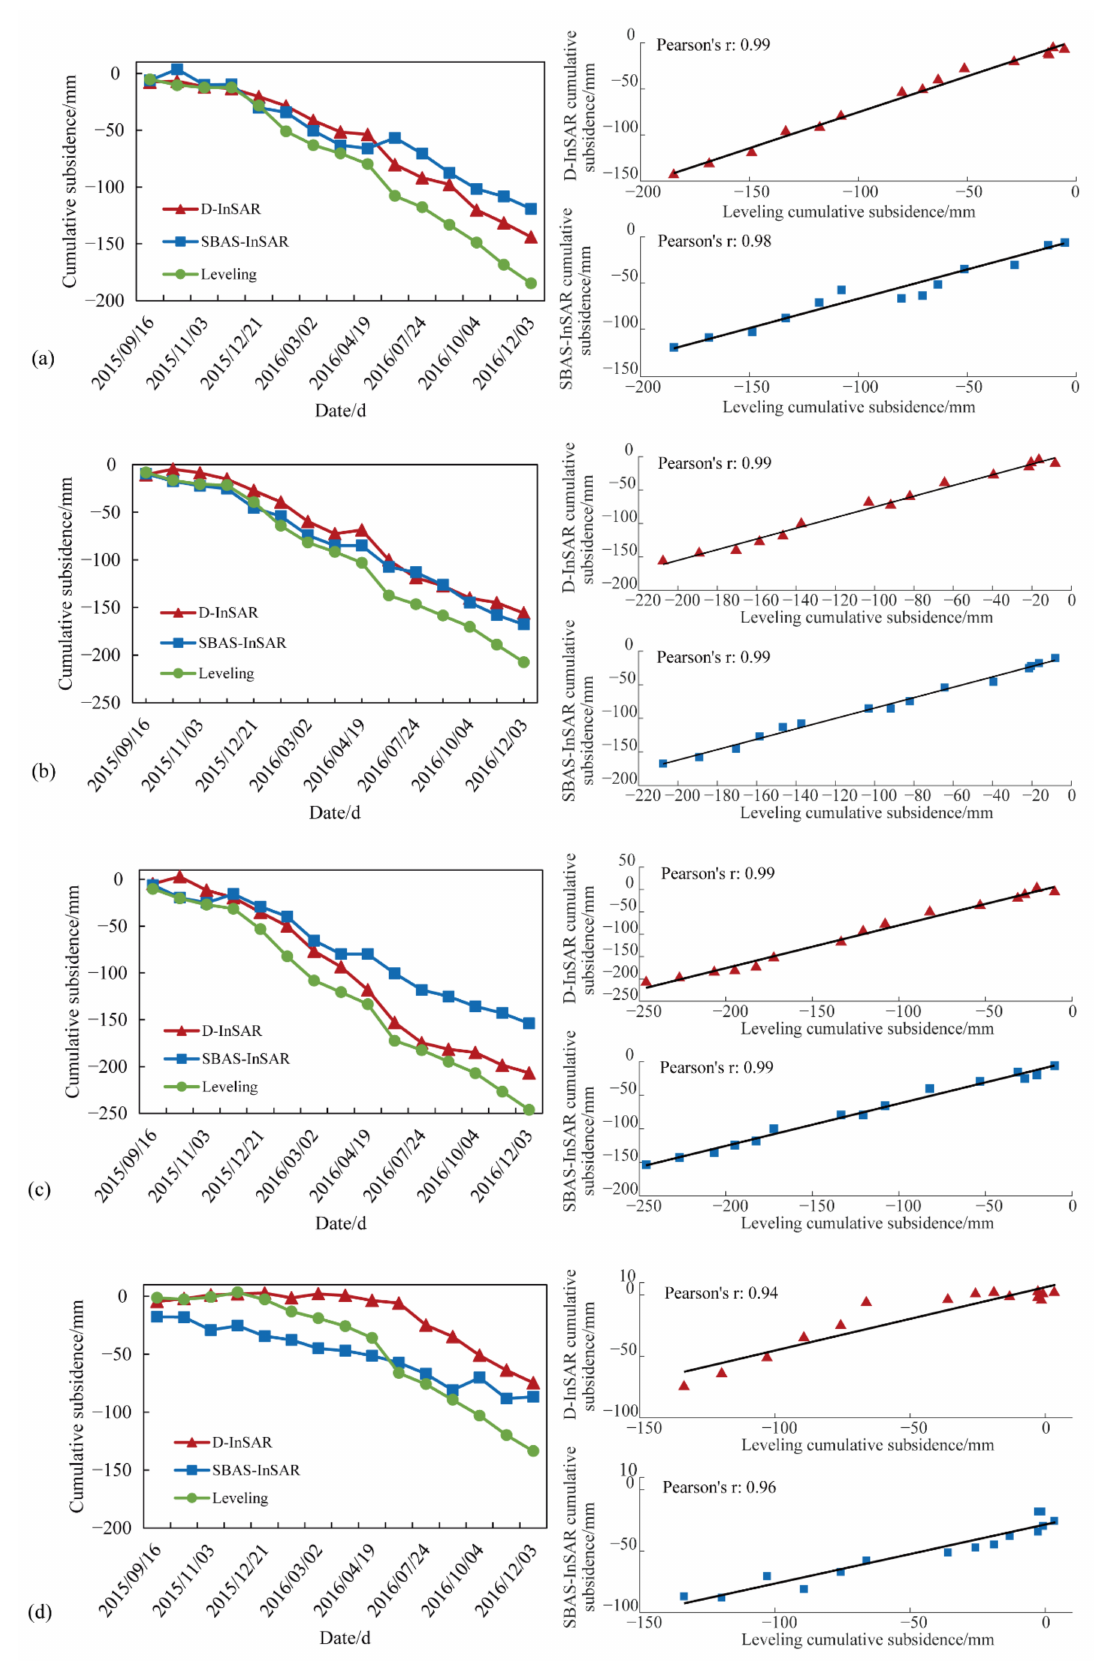
Figure 8. Comparison and correlation coefficients of subsidence curves monitored by D-InSAR, SBAS-InSAR and leveling: ( a ) point H9, ( b ) point H18, ( c ) point H24, and ( d ) point